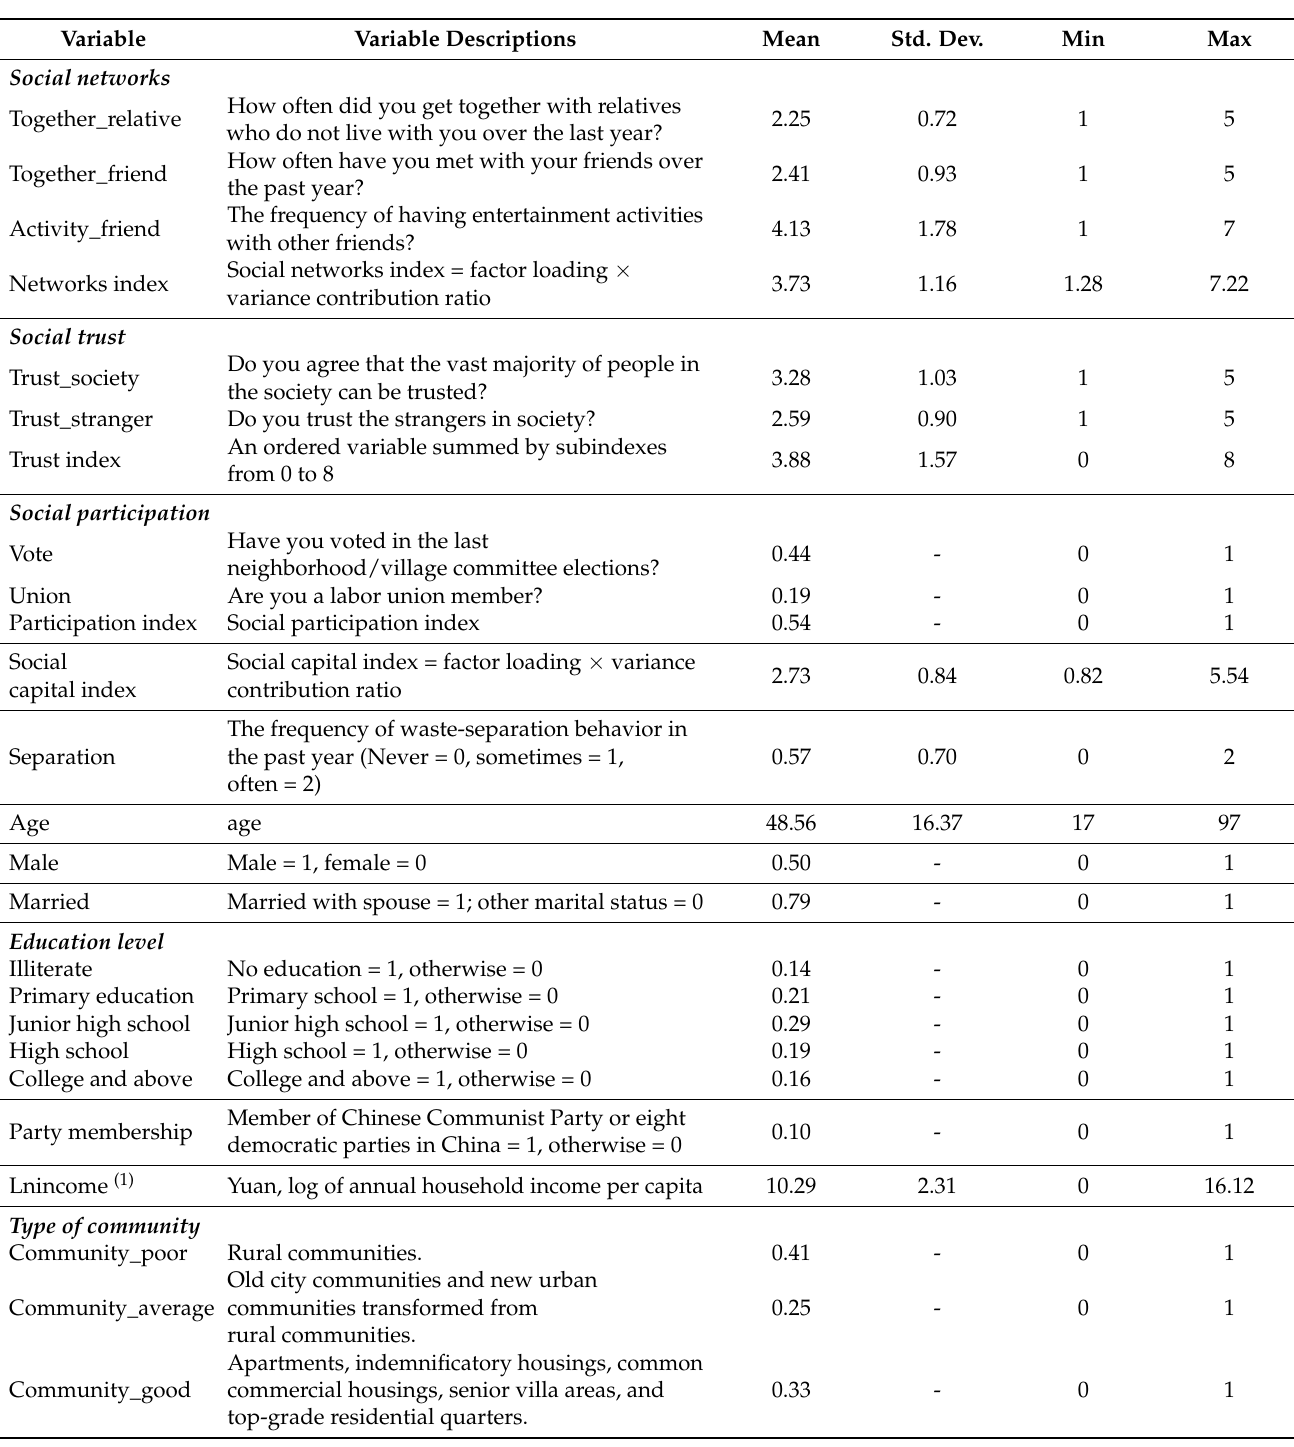
Table 2. Descriptive statistics of variables in the